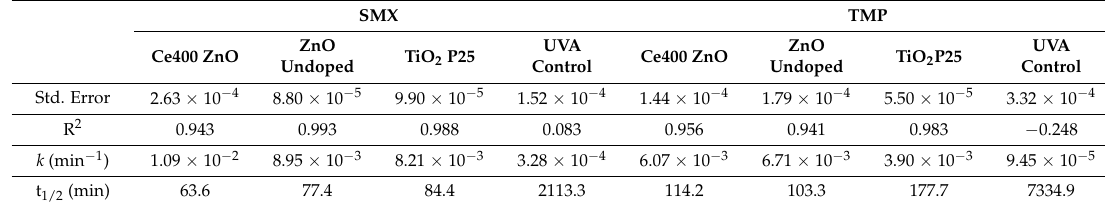
Table 1. Linear regression equations of Figure 3.